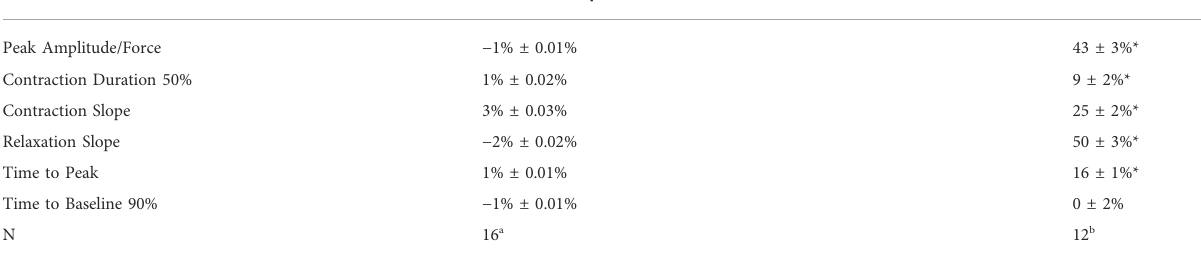
TABLE 1 Standard CCM signal contractile